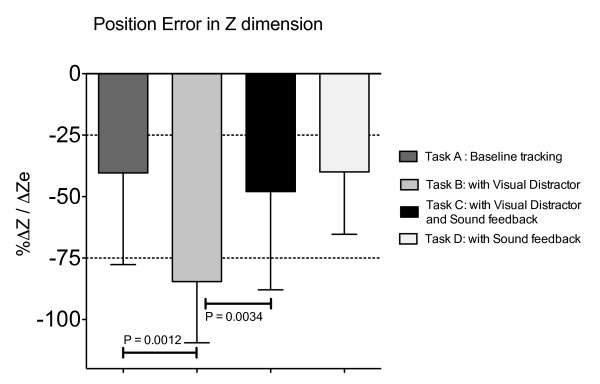
Tracking error in Z dimension. Position error for participants with stroke using their paretic arms to track, relative to tracking error when the participants completely relaxed their arms in Task E.